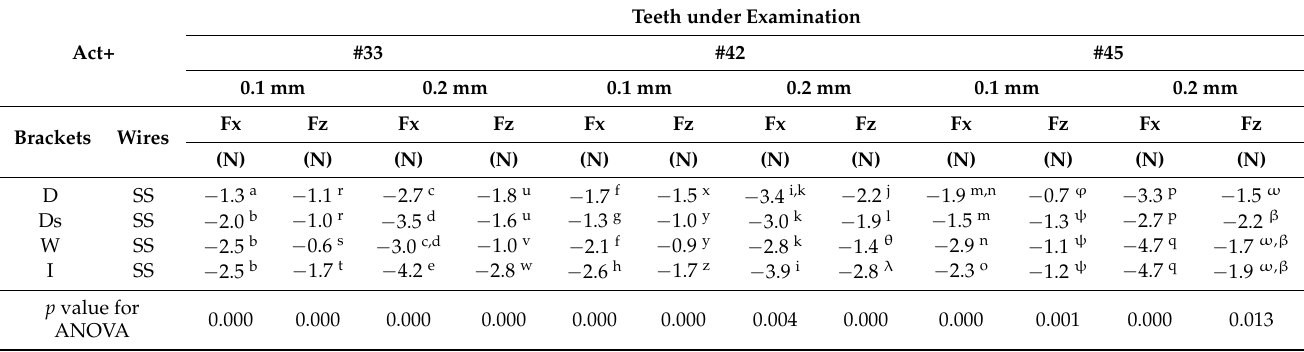
Table 4. Intrusion/extrusion and orovestibular force values generated during positive activation at a specific tooth (canine, lateral incisor and premolar) area using the four different bracket appliances combined with the stainless-steel wire at 0.1 mm and 0.2 mm.